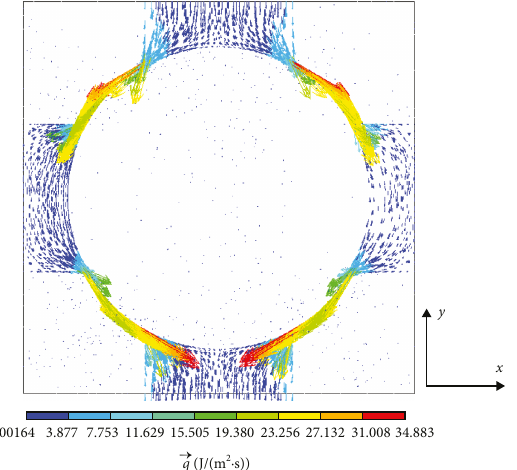
Figure 24: Pro fi le image of the heat fl ow vector of the crosslinked model.